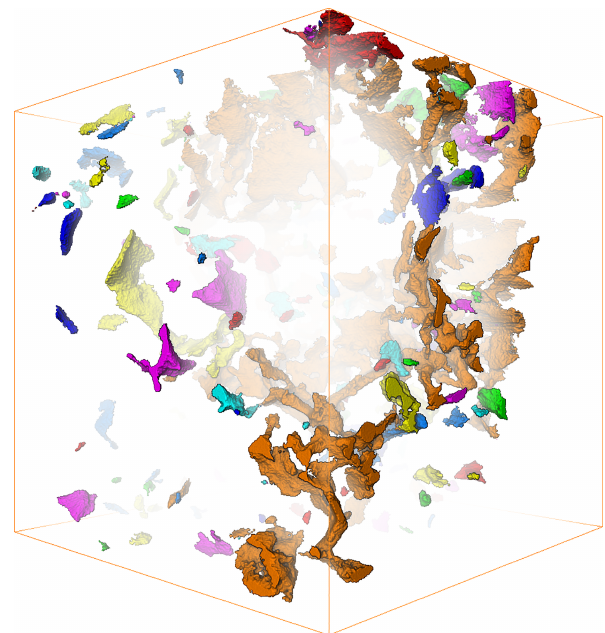
Figure 7. 3-D rendering of cavities segmented from a nanotomo- graphic dataset. Pores are coloured individually to highlight connec- tivity. This means that a single colour allows for the tracing out of pore connections. For example, note the large interconnected pore cluster in orange. The dimension of the cube is 700 voxel 3 , with a voxel size of ∼ 35nm. The top and base of the cube are parallel to the mylonitic foliation. The figure indicates the oblate shape of most cavities and proves that they are indeed 3-D